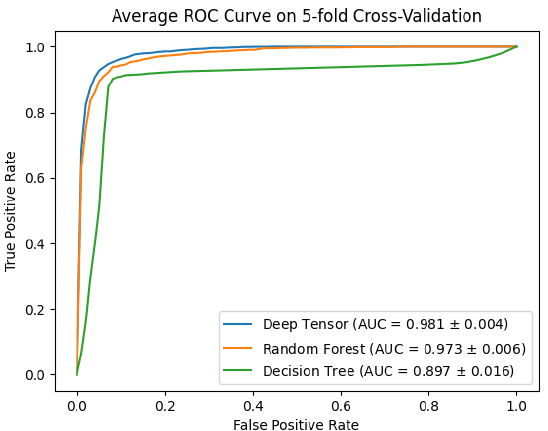
Figure 4. This details the estimation performance of deep tensor, decision trees, and random forests. The horizontal axis is the epoch parameter for deep tensor, and the depth parameter for decision trees and random forests. We varied the epoch or depth parameter and considered the highest estimation to be the performance of each method. These results are averages of a five-fold cross- validation.